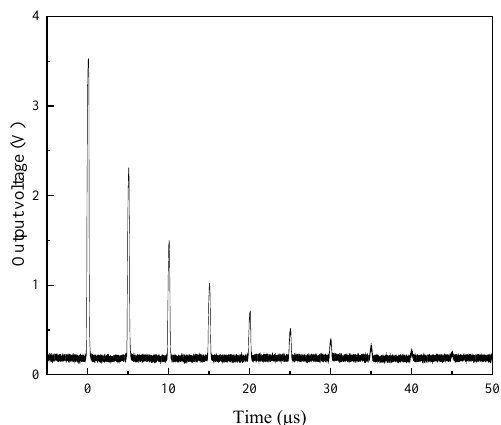
Figure 6. Original waveform under N 2 background gas.